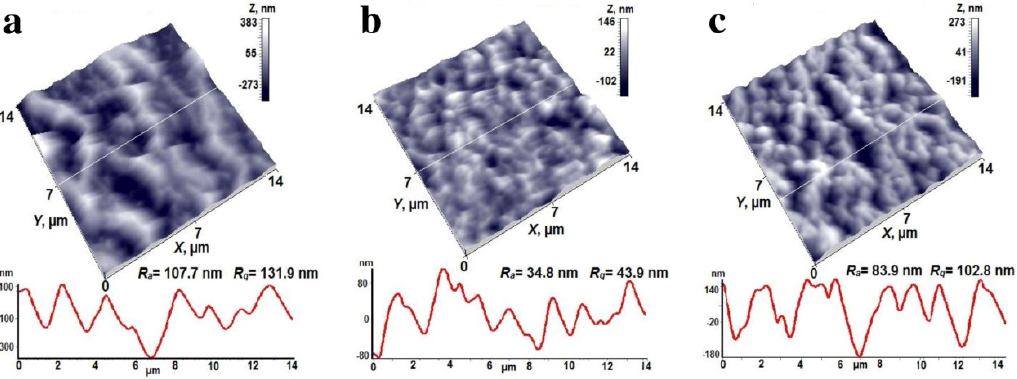
Figure 3. Atomic force 3D images and profiles of relief of PE ( a ), PP ( b ) and PVDF porous supports ( c ).